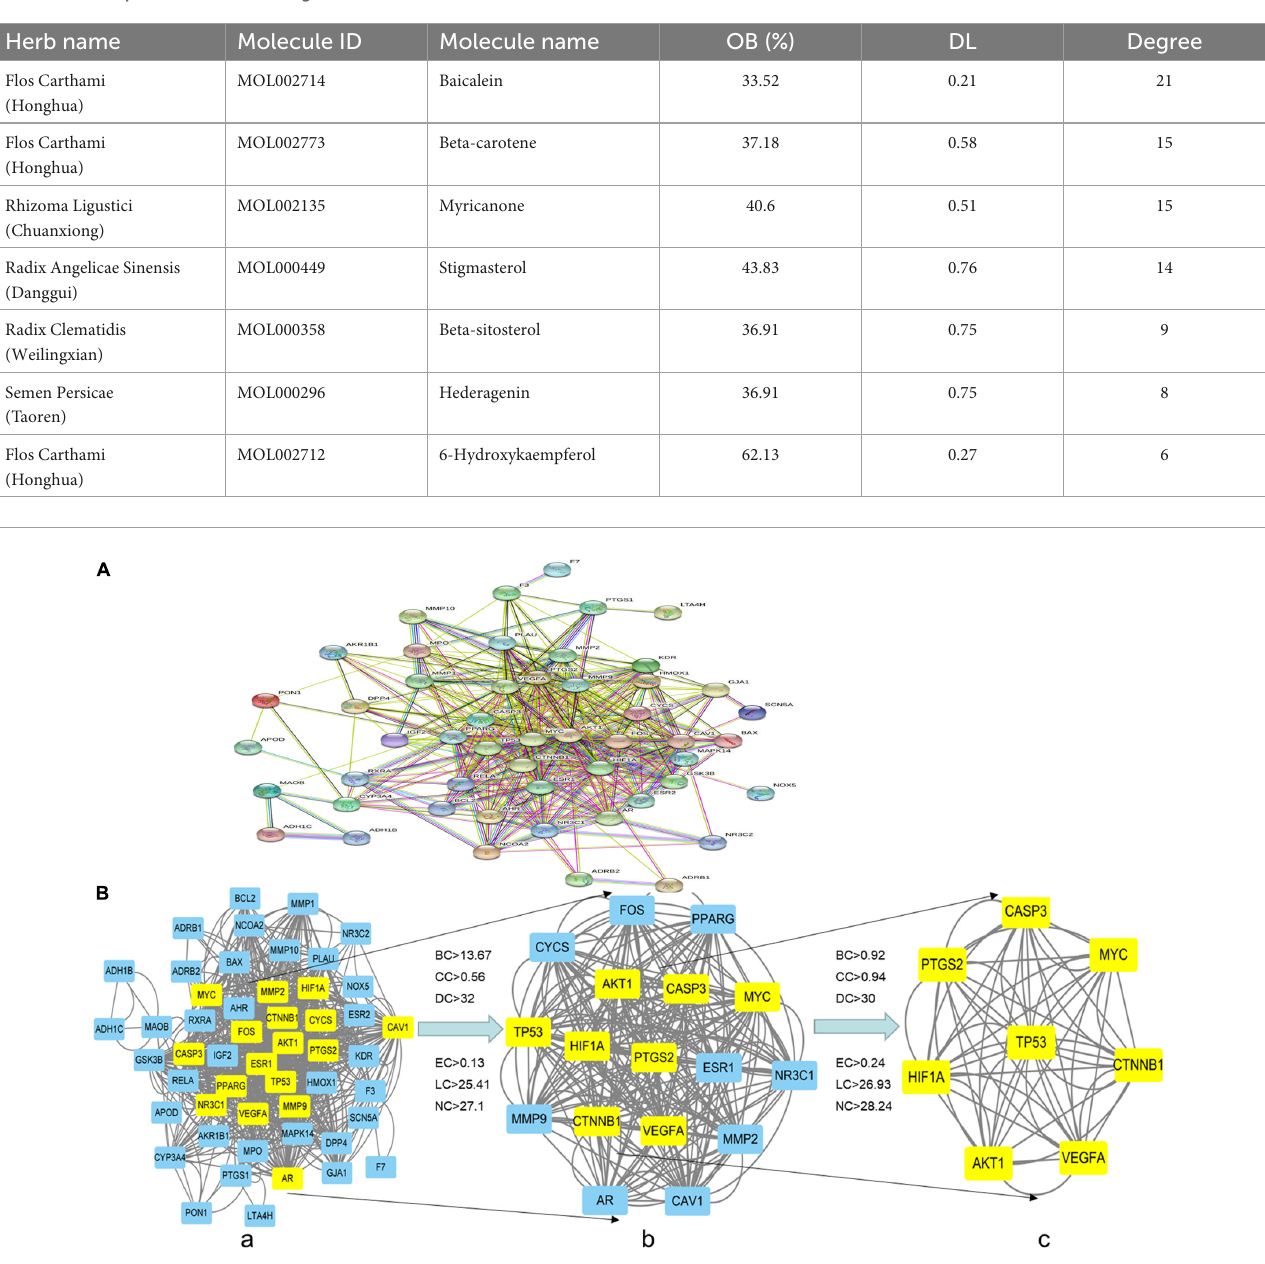
TABLE 2 The top seven core active ingredients of THD for the treatment of AS.